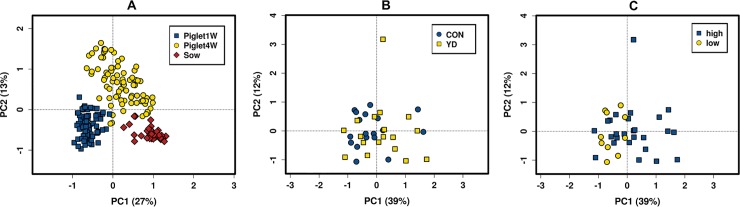
Bray-Curtis OUT’s level principal component analysis (PCA).(A) Individual fecal samples of sow, piglets at one week and four weeks of age. (B) Individual sow fecal samples in the control group and YD group. (C) Individual sow fecal samples based on the sow colostrum yield, high (≥ 3500 g) and low (< 3500 g).